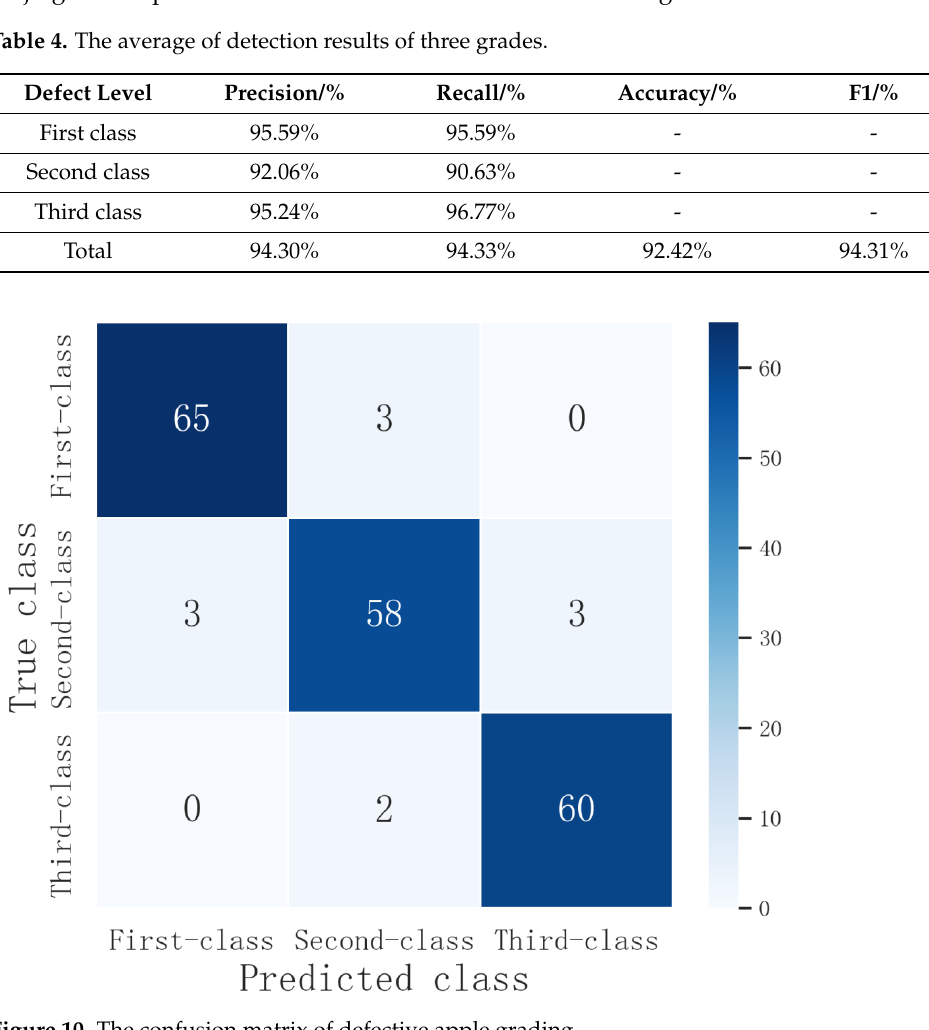
Figure 10. The confusion matrix of defective apple grading. As shown in Table 4, the precision and recall in the three grades of apples were above 90.63%, and the overall precision and recall were 94.30% and 94.33%, respectively. The detection accuracy of apples was 92.42%, and the F1 value was 94.31%. Among the three grades, the apple grade identification with the highest precision was the first-class apples (95.59%), and the ones with lowest precision were second-class apples (92.06%). Due to the error that would occur when the area values of defect were close to the junction of two adjacent grades, first class and third class might be misclassified into second class, and second-class could also be misclassified into first class and third class. Meanwhile, if the defect was located at the edge of apple, it was sometimes incorrectly detected as the back- ground by the object-detection algorithm and semantic segmentation model, which would also lead to the reduction of classification accuracy.